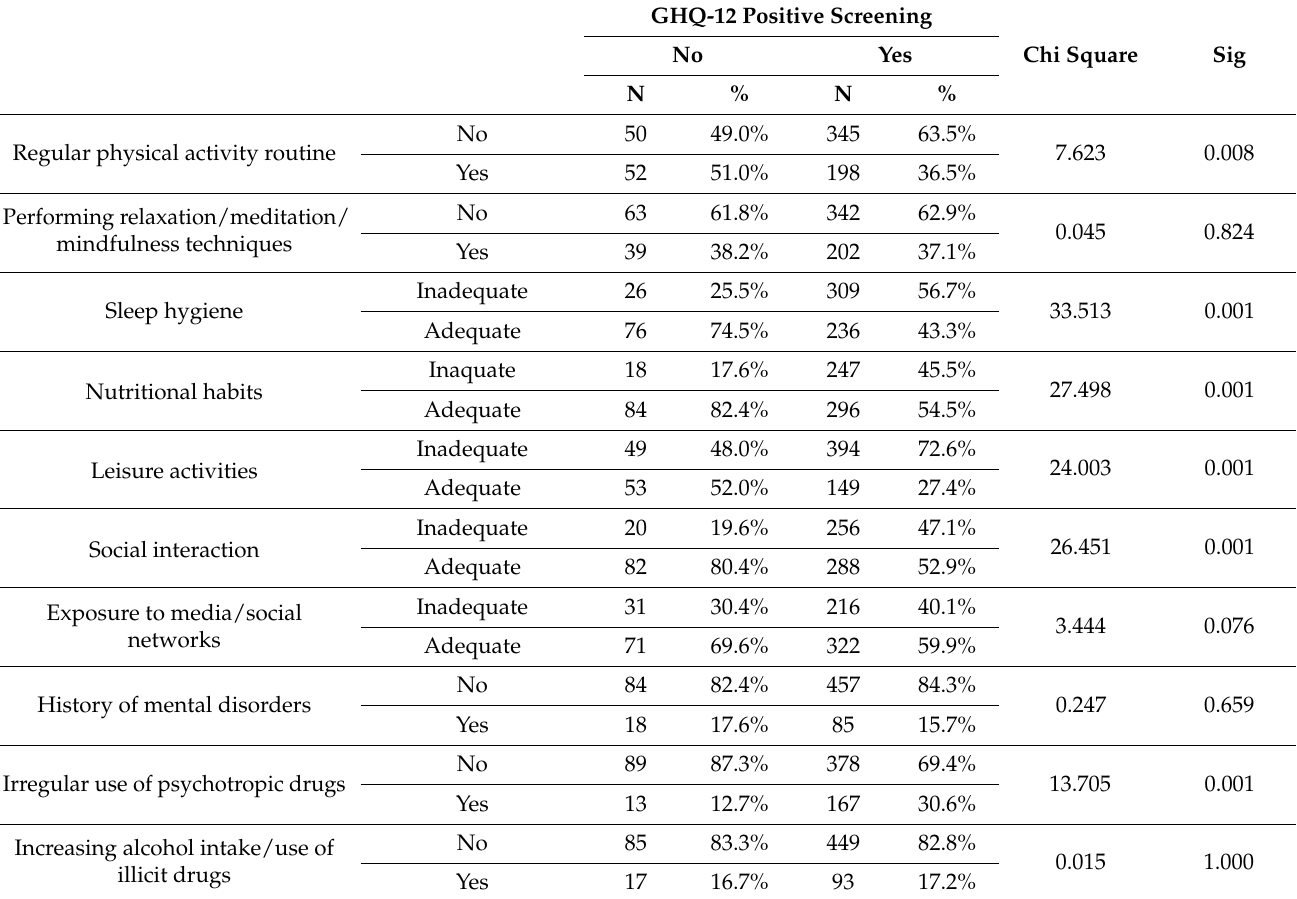
Table 2. Bivariate analysis results: protective habits and risk behaviors. GHQ-12 Positive